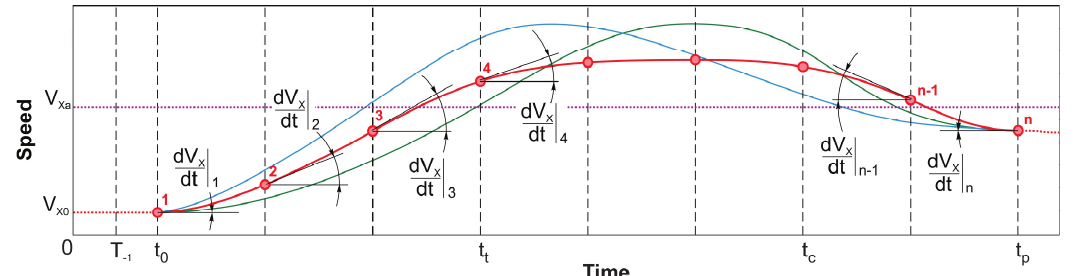
Figure 6. Different speed plan distributions with fixed values of t p and X p . Figure 6. Di ff erent speed plan distributions with fixed values of t p and X p